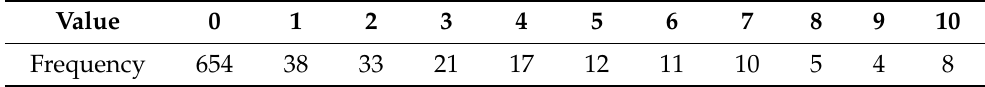
Table 1. Parasite intensity